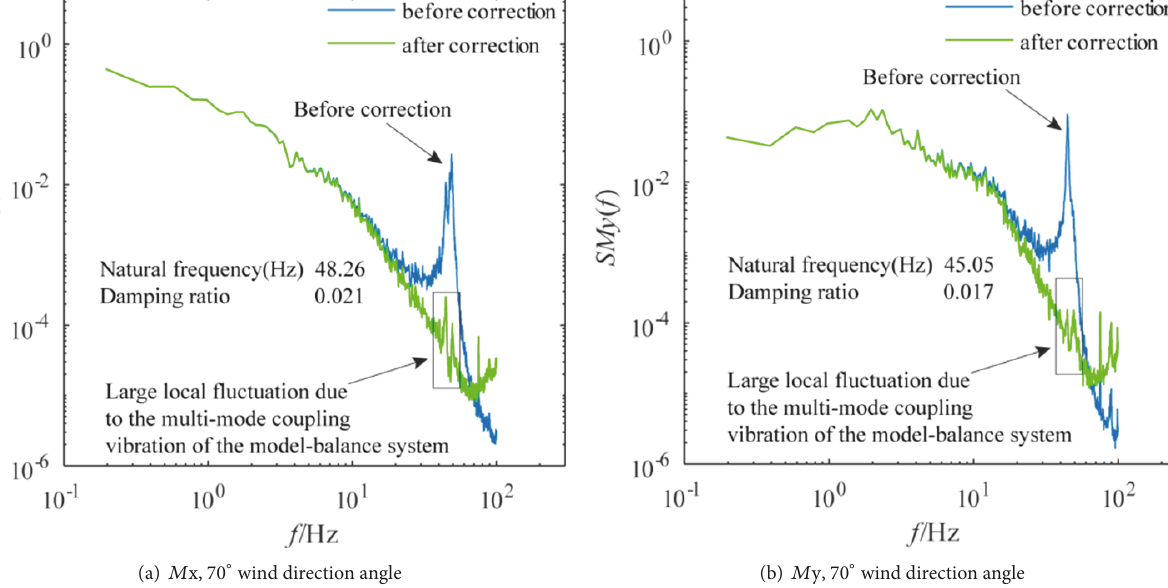
Figure 9: The correction effect of the base overturning moment of Guangzhou East Tower at 70 ∘ wind direction angle before